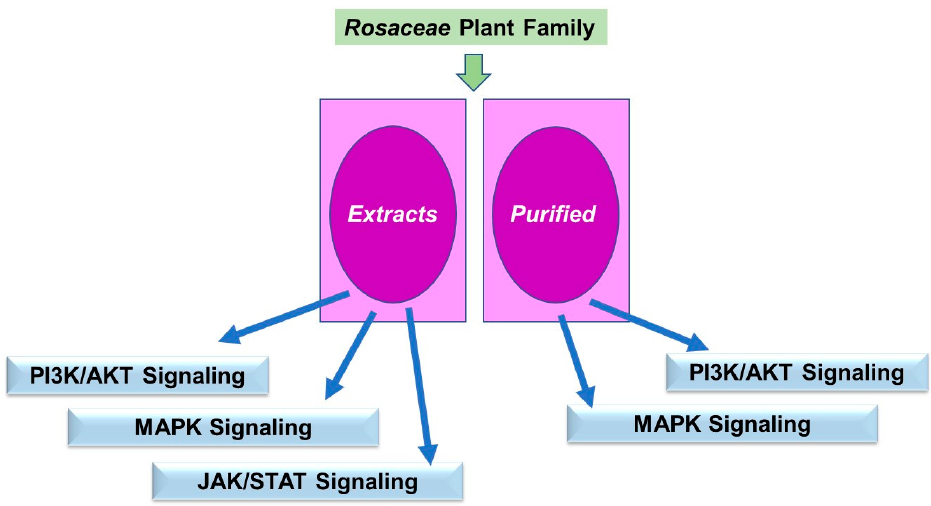
Figure 11. A schematic summary of the effects of metabolites from the Rosaceae on the MAPK, PI3K/AKT, and JAK/STAT signal transduction pathways. PI3K/AKT, and JAK/STAT signal transduction